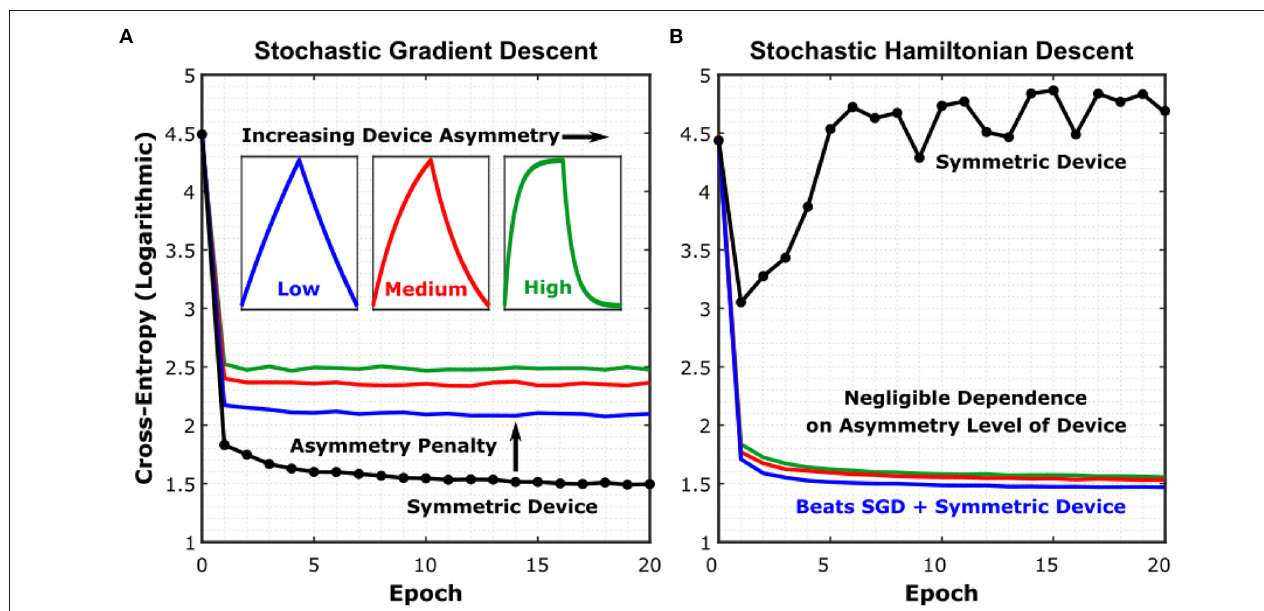
FIGURE 4 | Simulated training results for different resistive device technologies. (A) Simulated learning curves of a Long Short-Term Memory (LSTM) network trained on Leo Tolstoy’s War and Peace novel, using different crosspoint device models under the SGD algorithm. Details of the network can be found in Karpathy et al. (2015). (B) Simulated learning curves for the same network using the SHD algorithm. All simulation details can be found in Section M3. Training Simulator and LSTM Network. See Supplementary Figure S4 for device-to-device variation included in the simulations and Supplementary Figure S6 for floating-point baseline comparison.